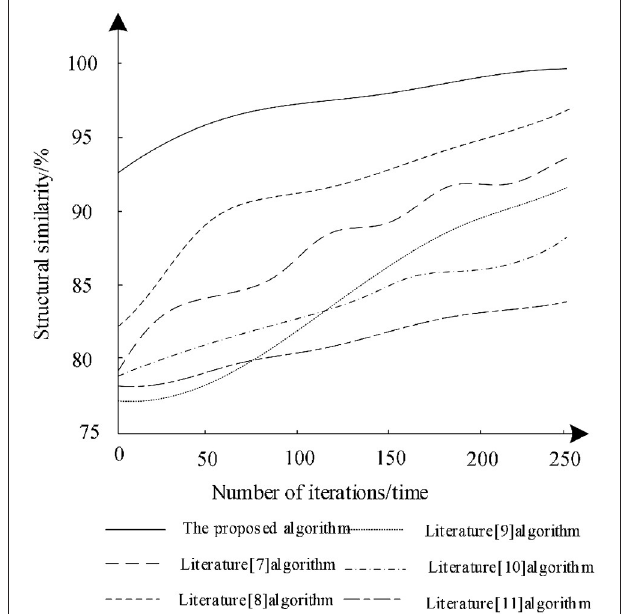
FIGURE 4 | Comparison of structural similarity of different algorithms.